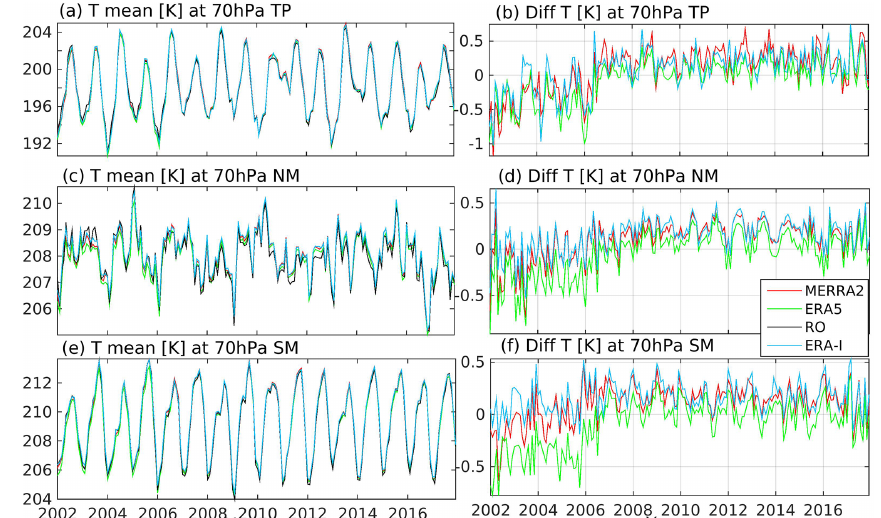
Figure 3. As in Fig. 1 but for